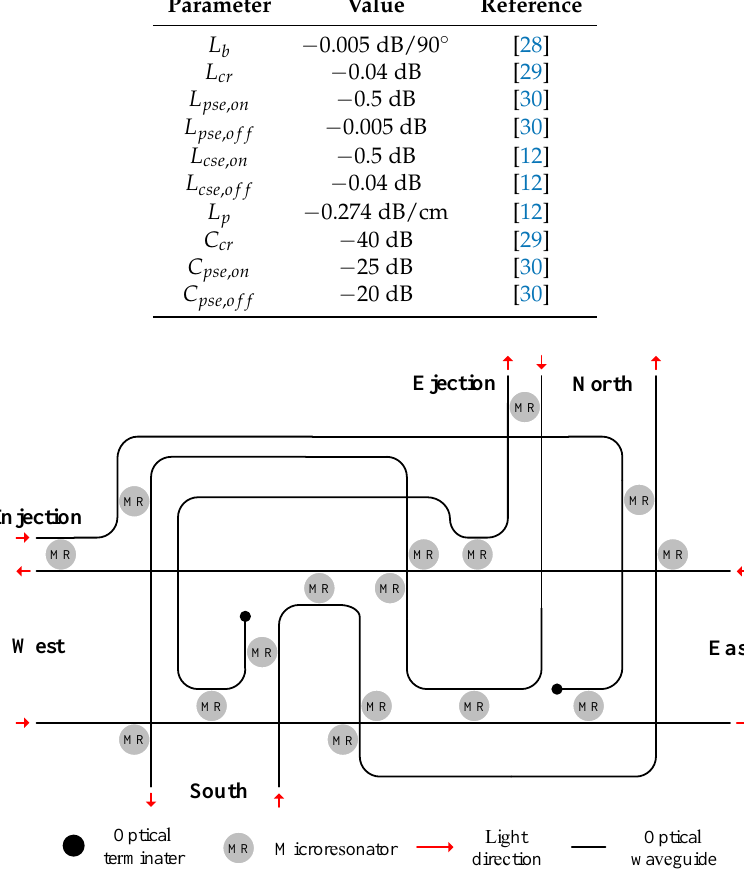
Figure 3. Cygnus optical